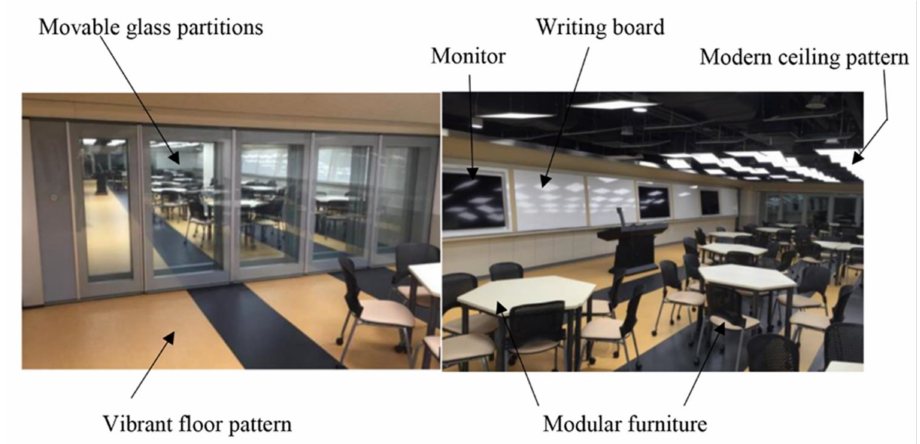
Figure 3. Reconfiguring of classrooms (N-001, N-002, and N-003).